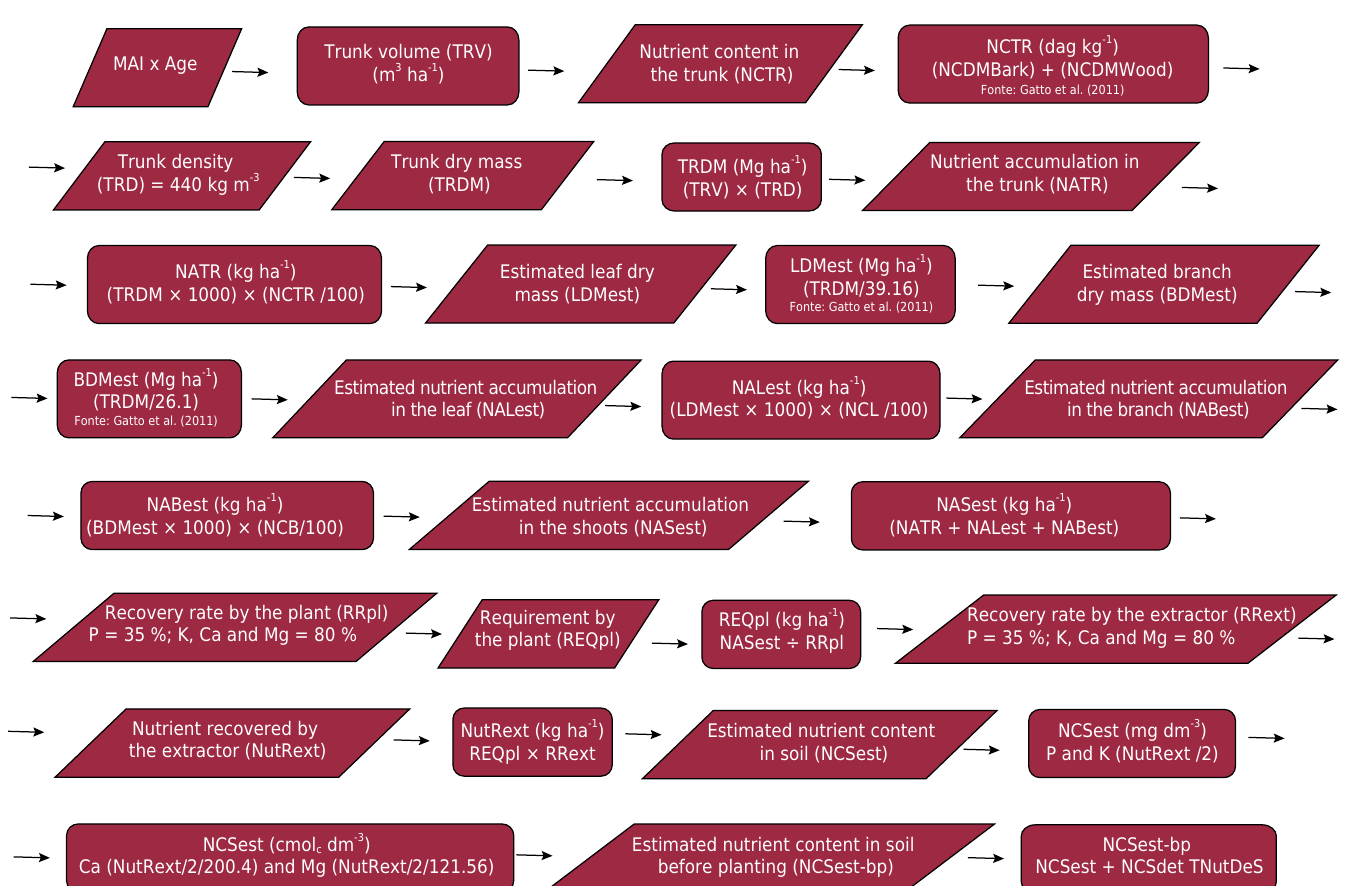
Figure 1. Flowchart of the steps used to obtain the estimated contents of nutrients (P, K + , Ca 2+ , and Mg 2+ ) in the soil in the 0.00-0.20 m layer before